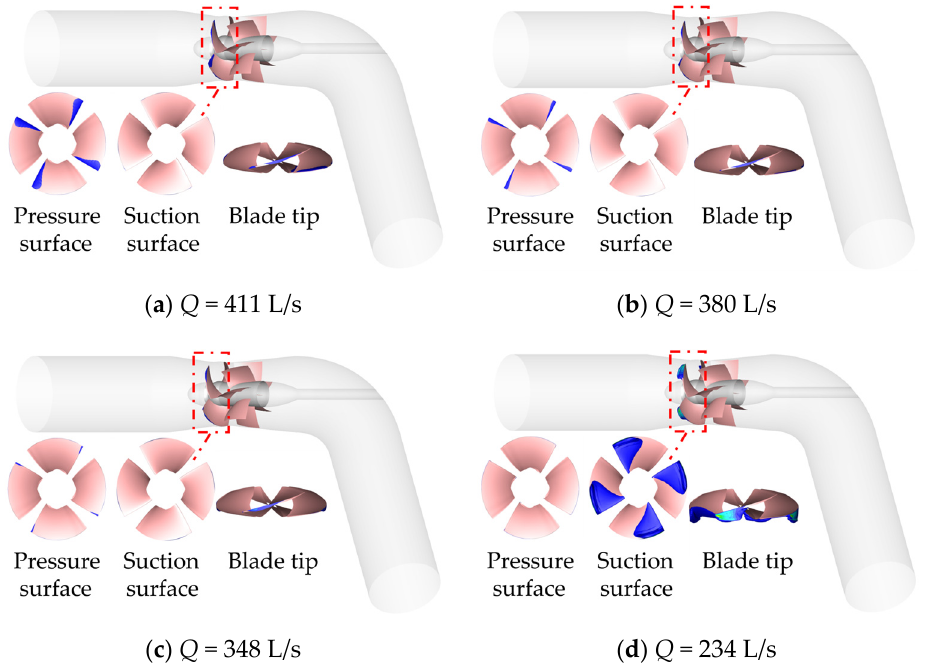
Figure 11. Air bubble distribution volume cloud diagrams at p in = 8 × 10 4 Pa.